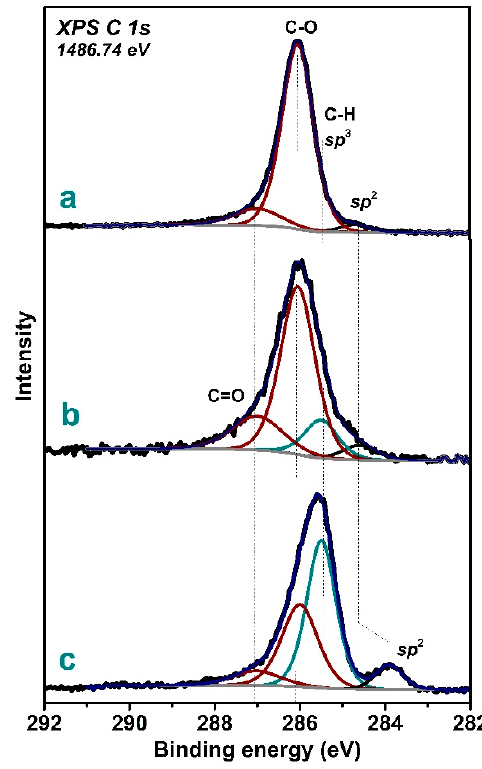
Figure 5. XPS C 1s spectra of Sample 1 ( a ), Sample 2 ( b ), and Sample 3 ( c ) grown at different parameters of gas-jet synthesis.